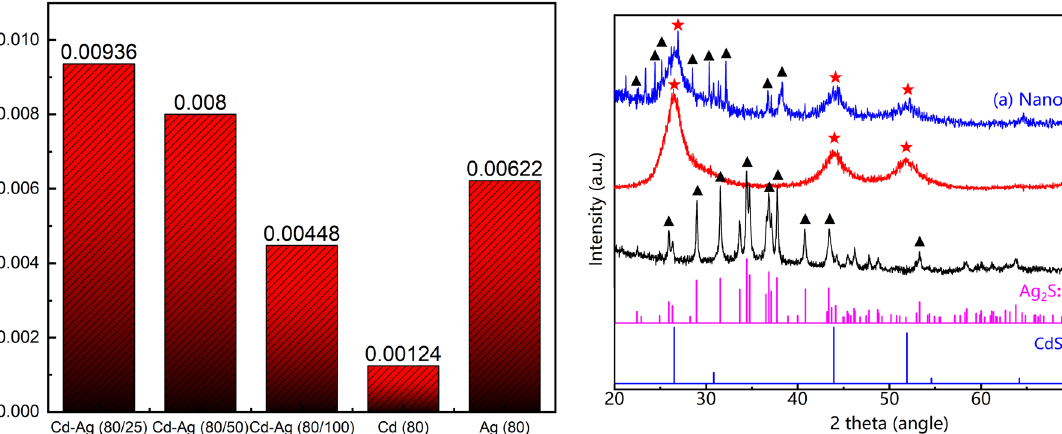
Figure 3: XRD patterns of di ff erent samples: ( a ) nanocomposites; ( b ) CdS; ( c ) Ag 2